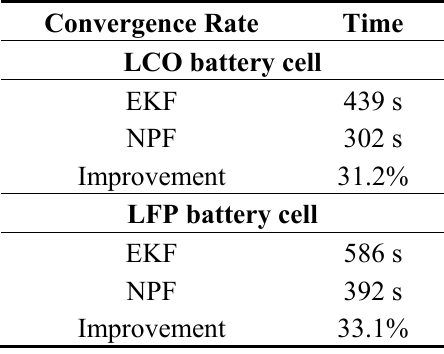
Figure 16. Comparison results of SOC estimation with inaccurate initial SOC: ( a ) SOC estimation of LCO battery cell; ( b ) SOC estimation error of LCO battery cell; ( c ) SOC estimation of LFP battery cell; ( d ) SOC estimation error of LFP battery cell. Table 6. Comparison results of convergence